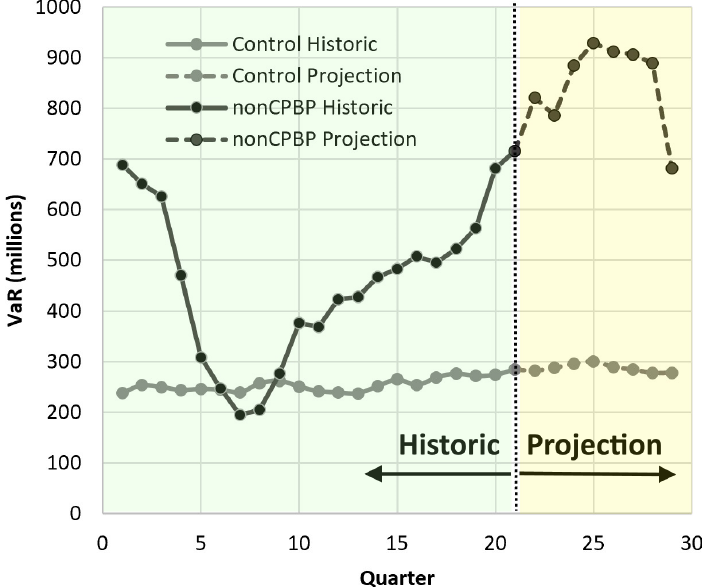
Figure 4. Historic nonCPBP and control data with 1- and 2-year Loess projections under no stress: Historic data (left of the vertical line) is shown in green, and projected data (right of the vertical line) is shown in